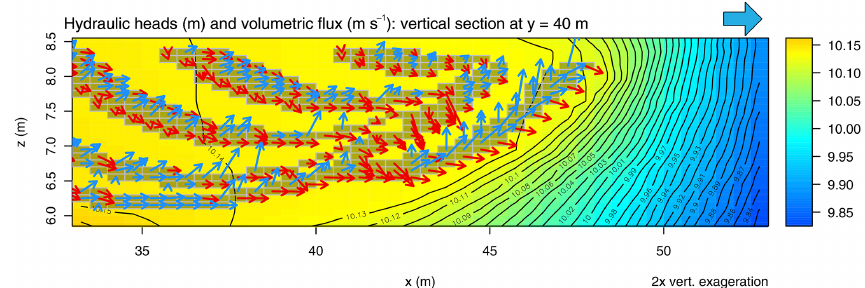
Figure 12. Enlarged view of the vertical section of the hydrogeological model along the x axis with the hydraulic head contours (every 0.01m) superimposed on the hydraulic head values. The grey rectangles represent the open-framework cells. The arrows correspond to the volumetric flux vectors projected on the model section; red indicates that the flux flows downward, blue upward. The large blue arrow on top indicates the main flow